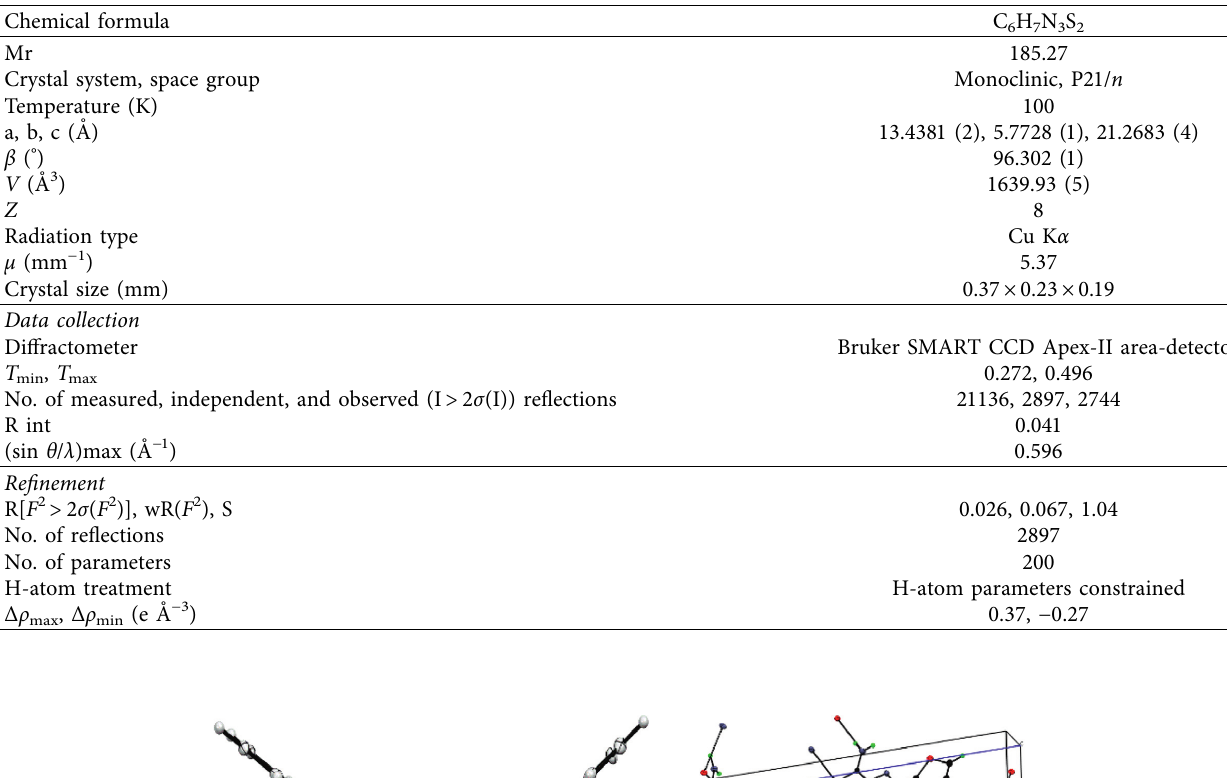
Table 2: Crystal data for L1 .